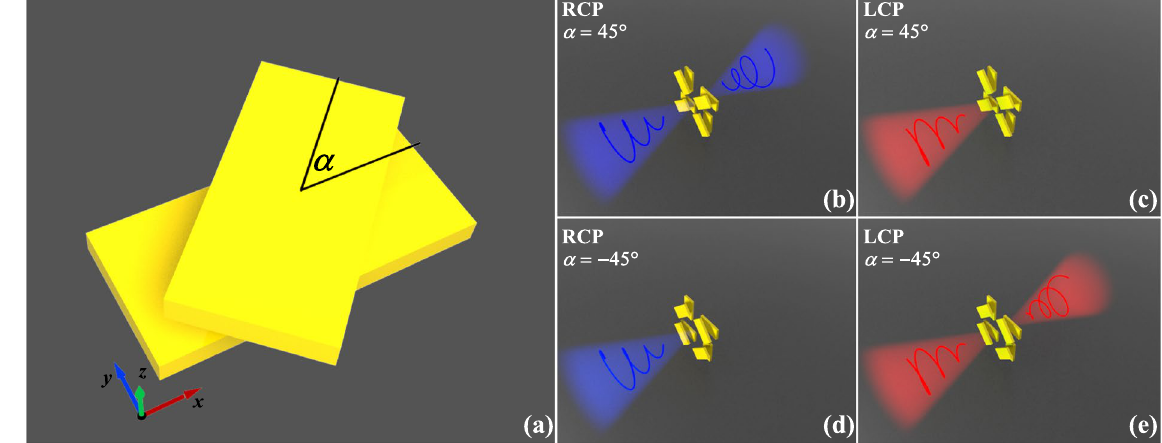
Figure 1. Design schematic for two-layer metasurfaces based on twisted nanorods. ( a ) The schematic of a twisted nanorod structure with orientation angle α . The designed two-layer metasurfaces, which are C 4 - symmetric, consist of four rotationally twisted nanorod structures with the same orientation angle. ( b ) to ( e ) Illustrations of spin-selective transmission in the two-layer metasurfaces for twisted nanorods with orientation angle α equal to 45° or − 45°. The chiral optical responses exhibited by these two metasurfaces are opposite; thus, they can be treated as